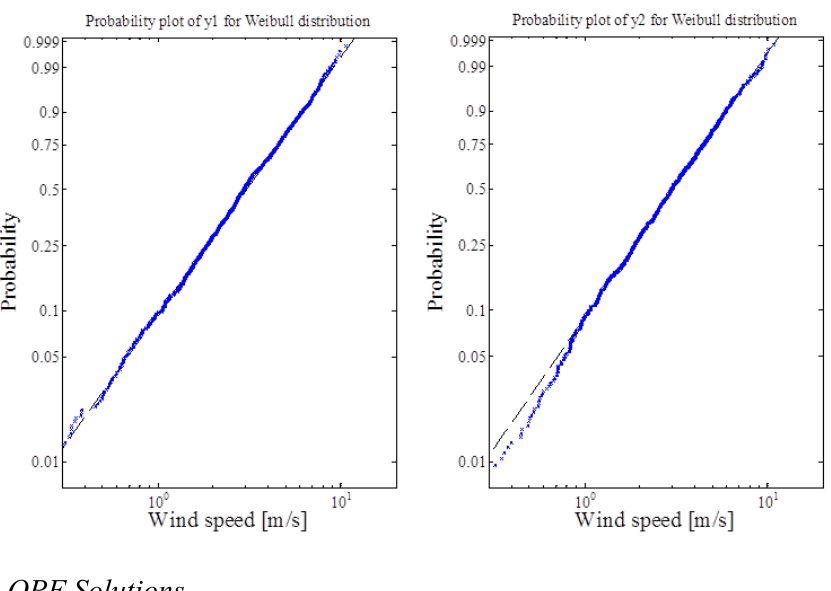
Figure 9. Probability plots for Weibull distributions y 1 and y 2 .